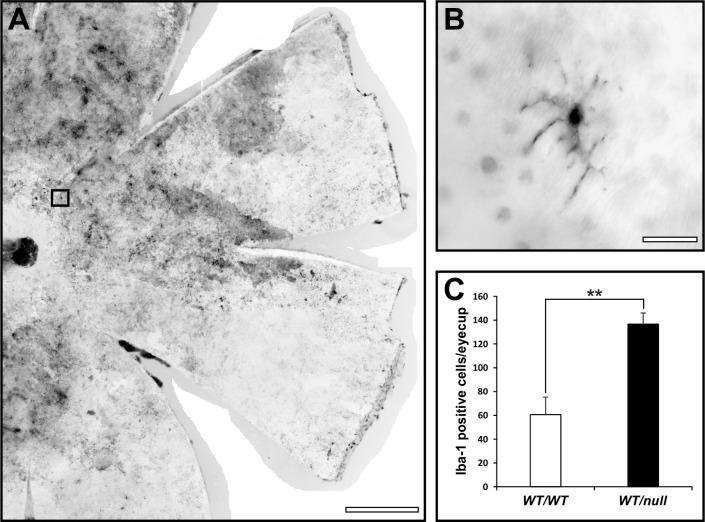
Elevated numbers of Iba1 positive glia in Chmnull/WT.(A) Flat mounted entire retinae from 6-month-old heterozygous null female mice were stained for the glial cell marker, Iba1. (B) High magnification of the boxed region in A indicates the stellate morphology of the glial cells. Scale bars: 500 μm (A) and 100μm (B). (C) Quantitation of glial cell numbers in heterozygous null female mice and age-matched controls reveals elevated numbers in Chmnull/WT. T-test: **p<0.01, n = 3.